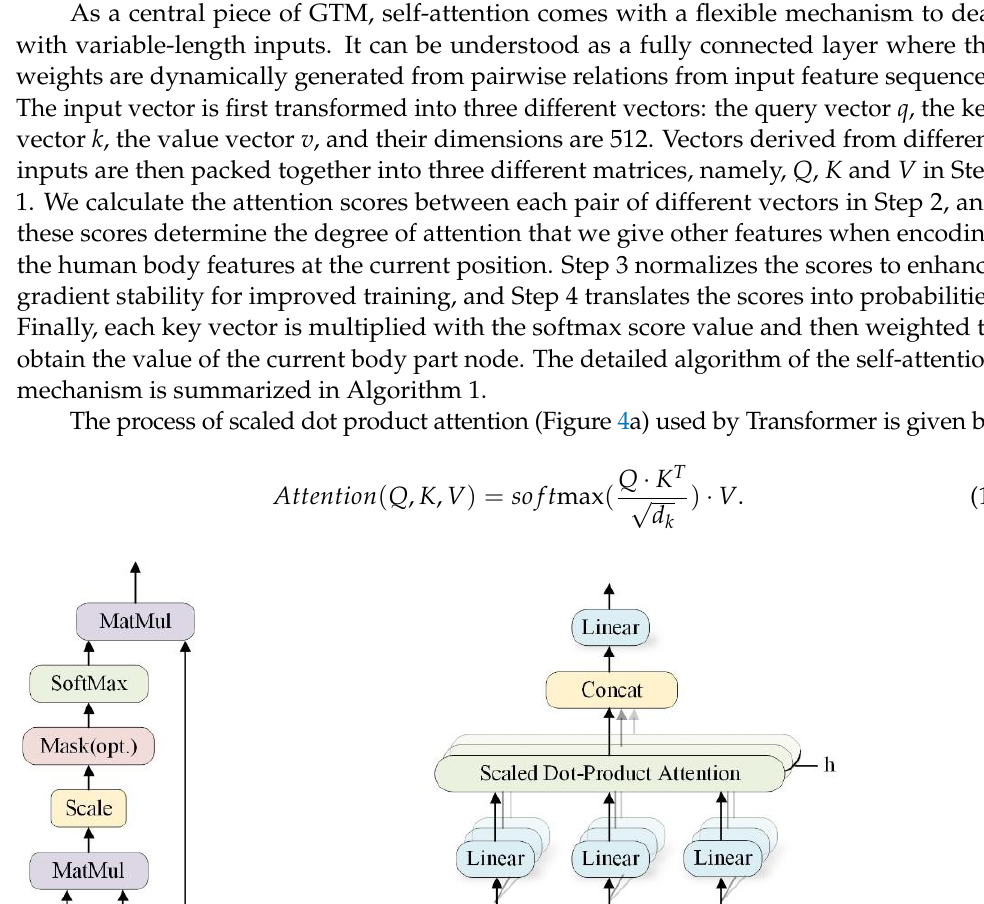
Figure 3. The architecture of GTM (Global Transformer Module). Algorithm 1: Self-Attention for Transformer